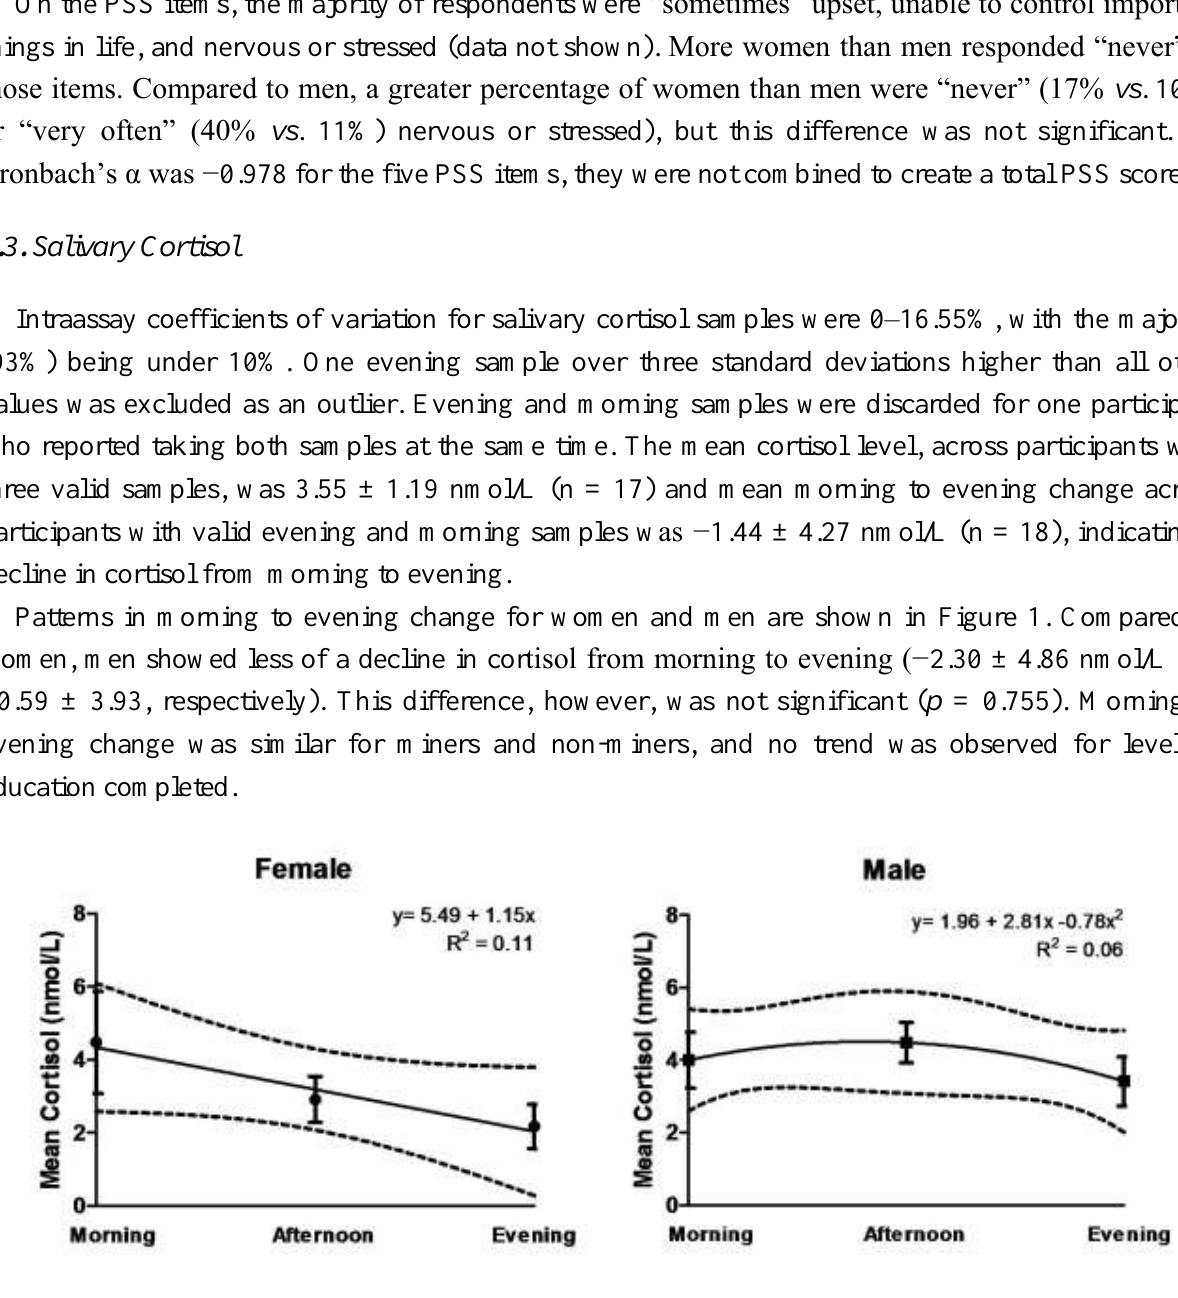
Figure 1. Change in salivary cortisol measurements over sampling period (morning to evening) for females (n = 9) and males (n = 8). Total duration between afternoon and morning samples ranged from 13.4–19.4